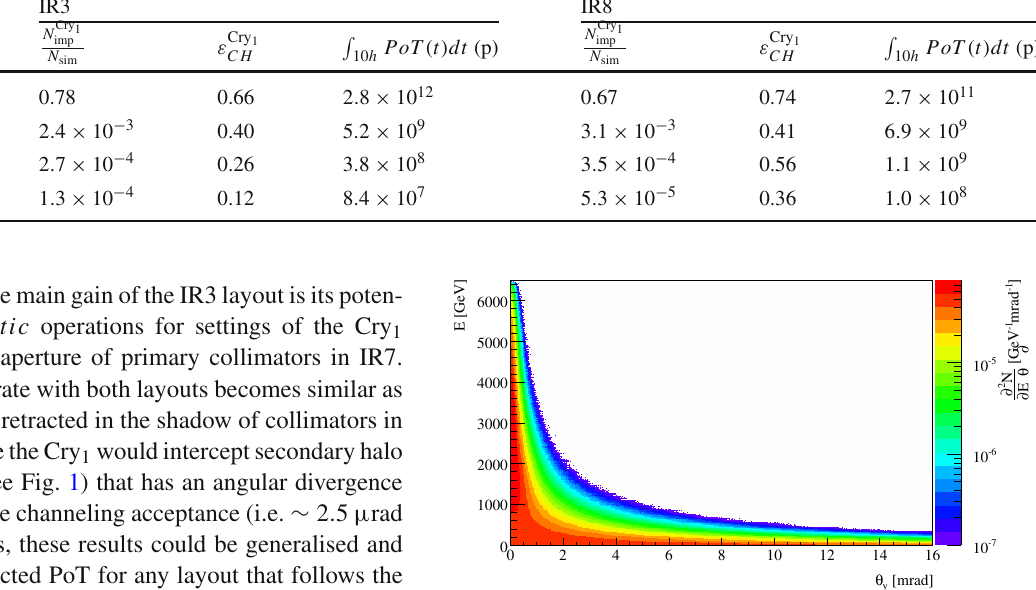
Table 5 Fraction of simulated protons that hit Cry 1 in both layouts and relative channeling efficiency, together with integrated PoT in a 10 h fill with 200 h beam lifetime. A total injected intensity of 2556 bunches Cry 1 aperture ( σ )